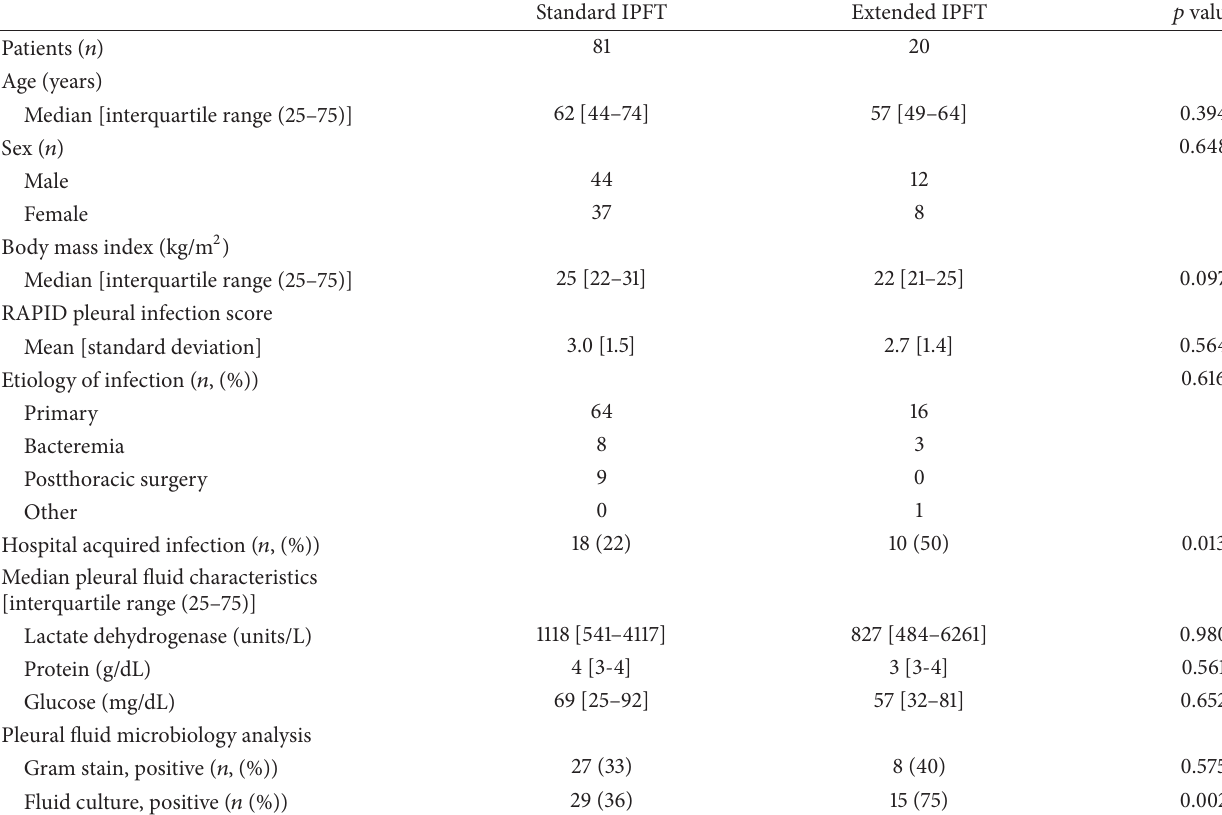
Table 1: Demographics of patients receiving intrapleural